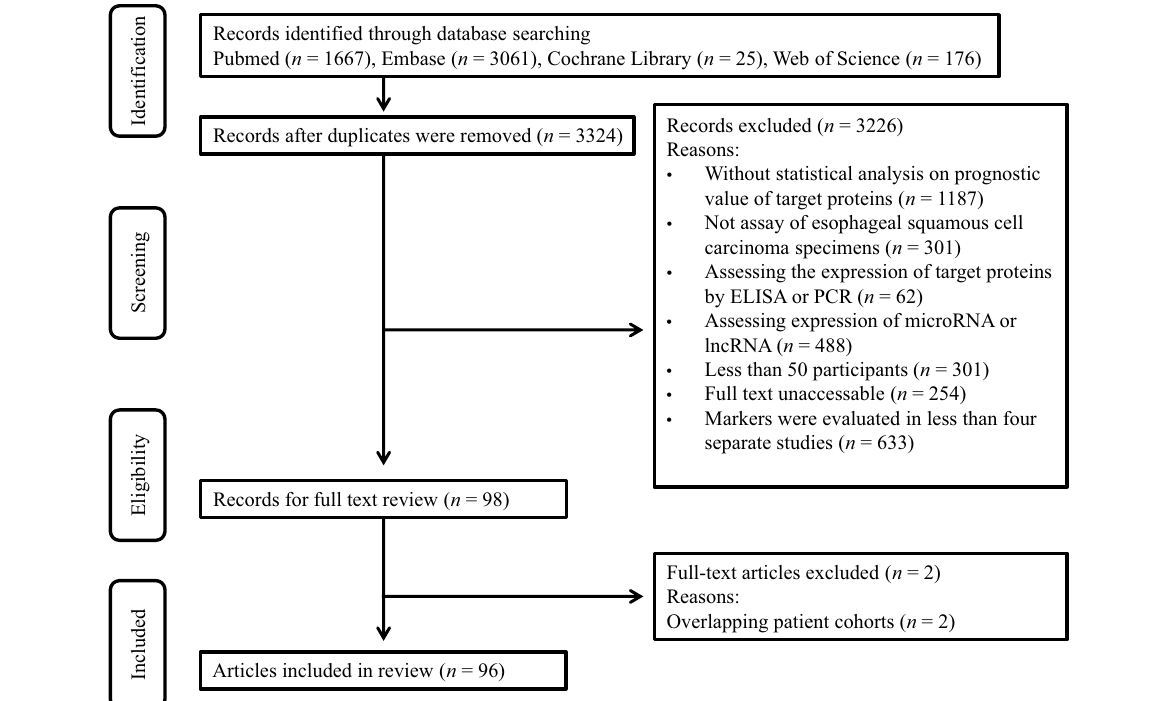
Fig. 1 Flowchart of study selection for this systematic review on immunohistochemical prognostic markers of esophageal squamous cell carci- noma. ELISA enzyme-linked immunosorbent assay, PCR polymerase chain reaction, lncRNA long non-coding